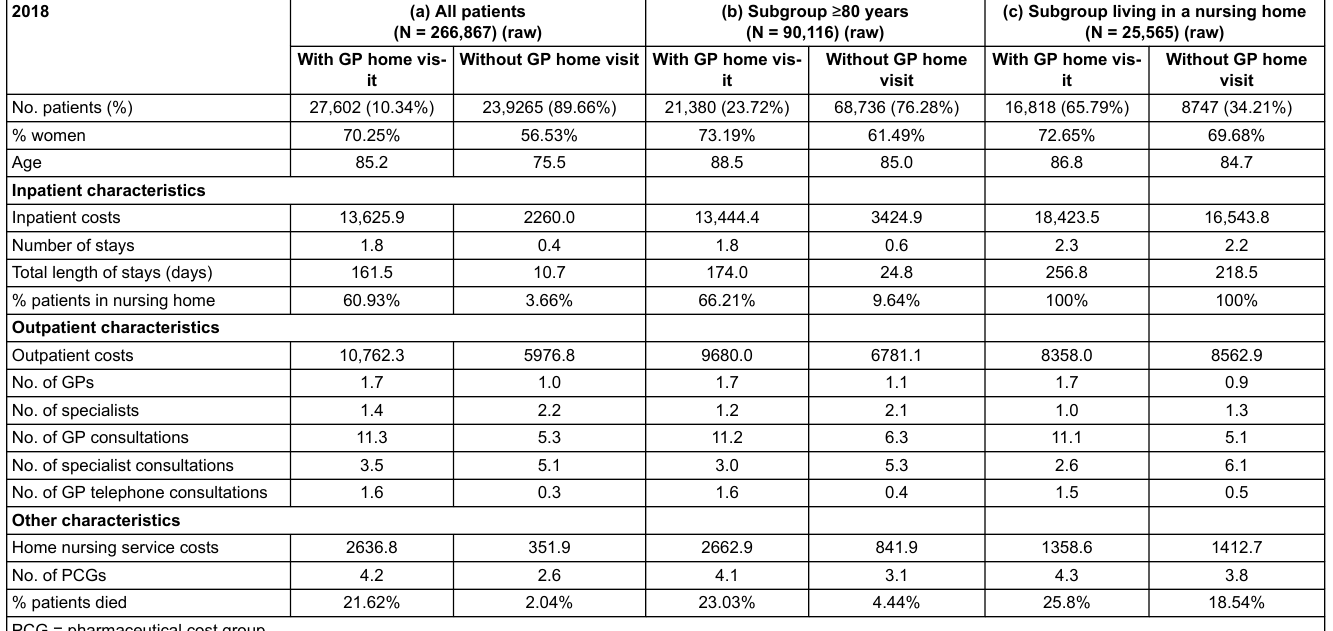
Table S4: Patient characteristics with regard to health conditions and healthcare utilization (year 2018) for (a) overall patients in the Helsana sample (aged ≥65 years); (b) sub- group of patients ≥80 years; (c) subgroup of patients living in a nursing home in the same year, 2018